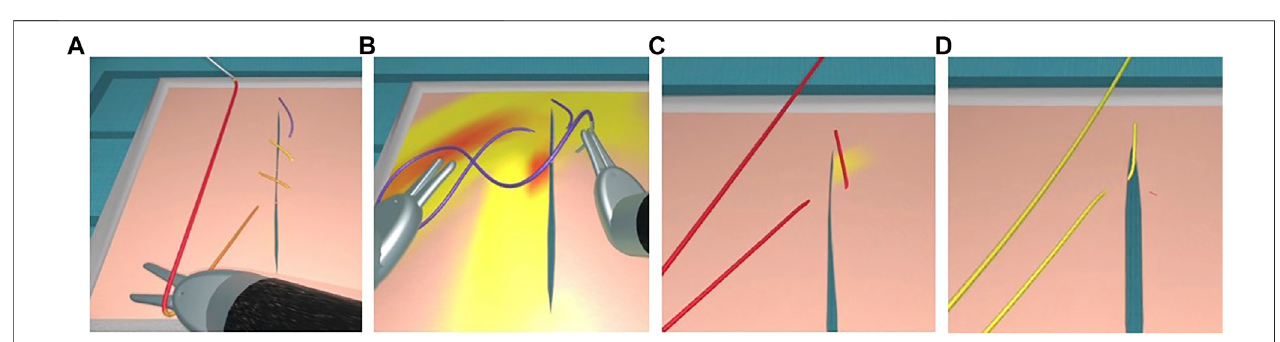
FIGURE13| Visualstressgradientsonathreadwhentighteningacontinuoussuture (A) ,andontissuewhendrivinganeedlethroughtissue(rightinstrument)while applying a counter-pressure (left instrument) (B) . Combined visual cues on thread and tissue when applying excessive force (C) leading to a tear in the tissue and subsequently reduced tension on the thread (D) .